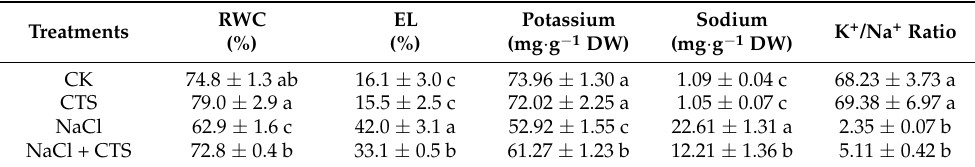
Table 2. Effects of chitosan (CTS) on leaf RWC, EL, and the contents of potassium and sodium in leaves of lettuce plants under salt